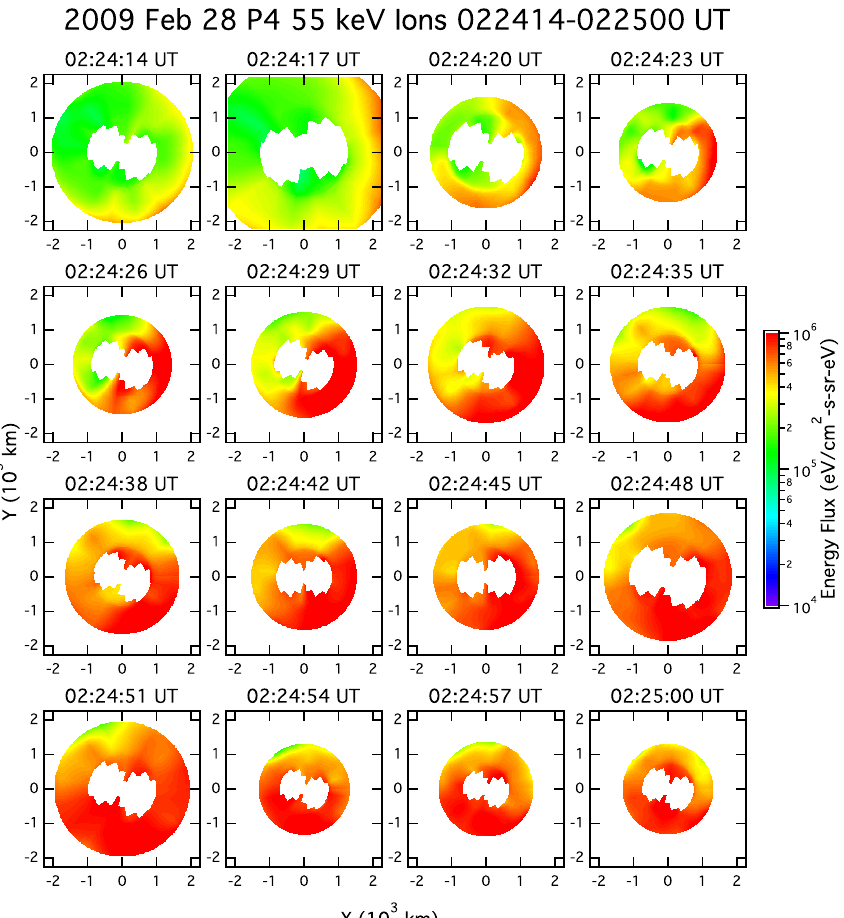
Fig. 3. Time evolution of energy fluxes for 50–60keV ions around the satellite THEMIS P4, constructed by mapping the measured energy fluxes to the particle’s